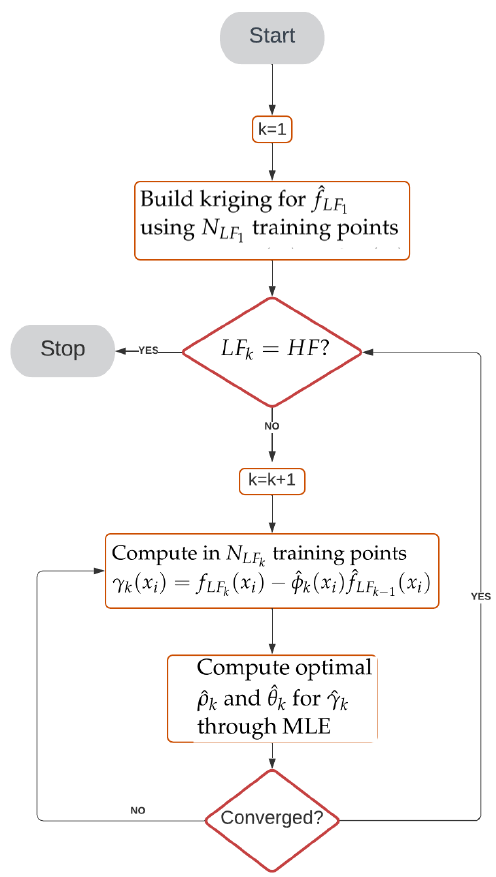
Figure 1. MF kriging algorithm